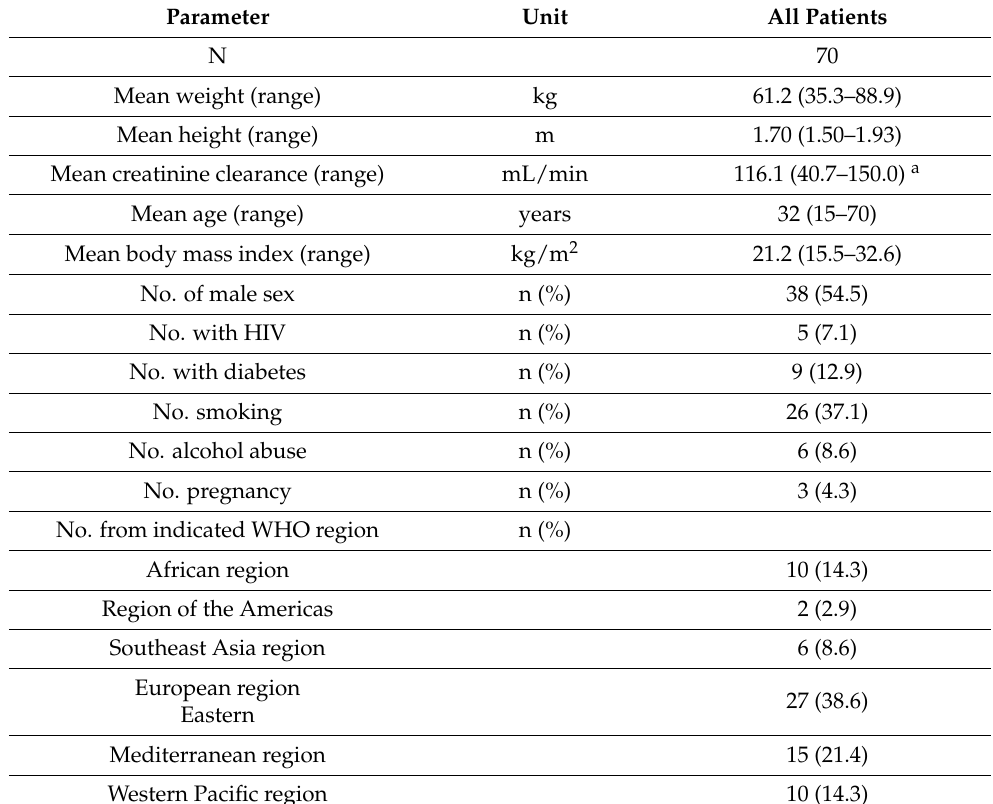
Table 1. Demographics and covariates for patients included in the data set used for population pharmacokinetic model